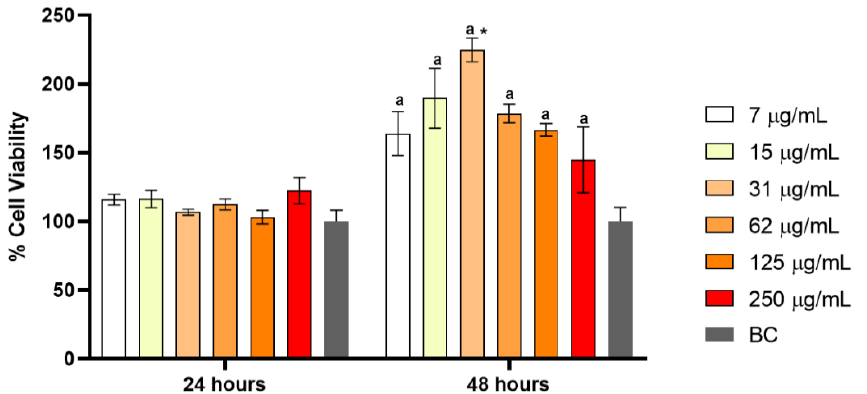
Figure 3. Cytotoxicity of nisin loaded in bacterial cellulose (N–BC) at concentrations of 7, 15, 31, 62, 125 and 250 µg/mL.; a p < 0.05 if compared to the respective concentrations at 24 h. * p < 0.05 if compared to the concentration of 7 µg/mL at 48 h.